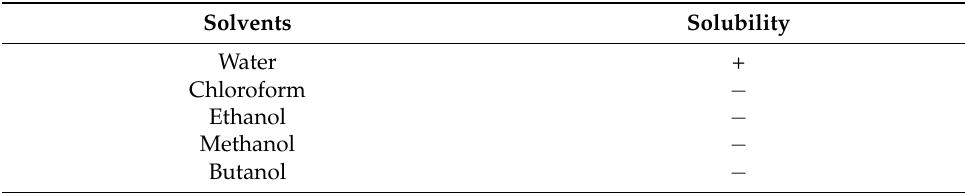
Table 1. Solubility of the purified bioflocculant. Solvents Solubility Water + Chloroform − Ethanol − Methanol − Butanol −